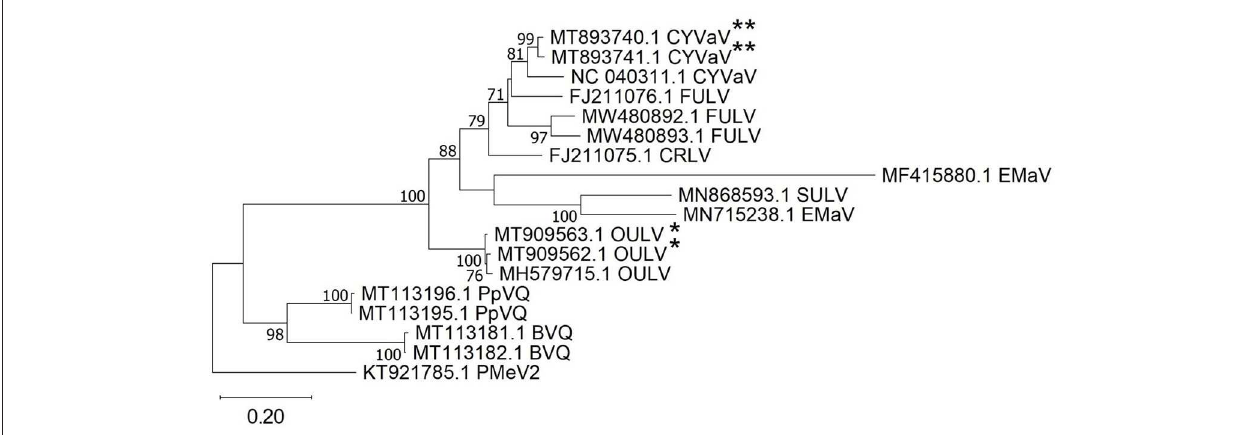
FIGURE 3 | Phylogenetic analysis of RNA-dependent RNA polymerase gene sequences of citrus yellow vein-associated virus (CYVaV) and opuntia umbra-like virus (OULV) were obtained from hemp samples collected during the 2019 field season in Colorado along with all top sequence matches of both detected viruses available in GenBank. Phylogenetic analysis by Maximum Likelihood method was done MUSCLE in MEGAX. Double asterisks indicate CYVaV and single asterisks indicate OULV genotypes from Colorado. Bootstrap values are indicated on the nodes. Scale bar indicates number of substitutions per site. Virus name abbreviations: BVQ, babaco virus Q; CRLV, carrot red leaf luteovirus; FULV, fig umbra-like virus; EMaV, Ethiopia maize-associated virus; PpVQ, papaya virus Q; PMeV2, papaya meleira virus2; SULV, sugarcane umbra-like